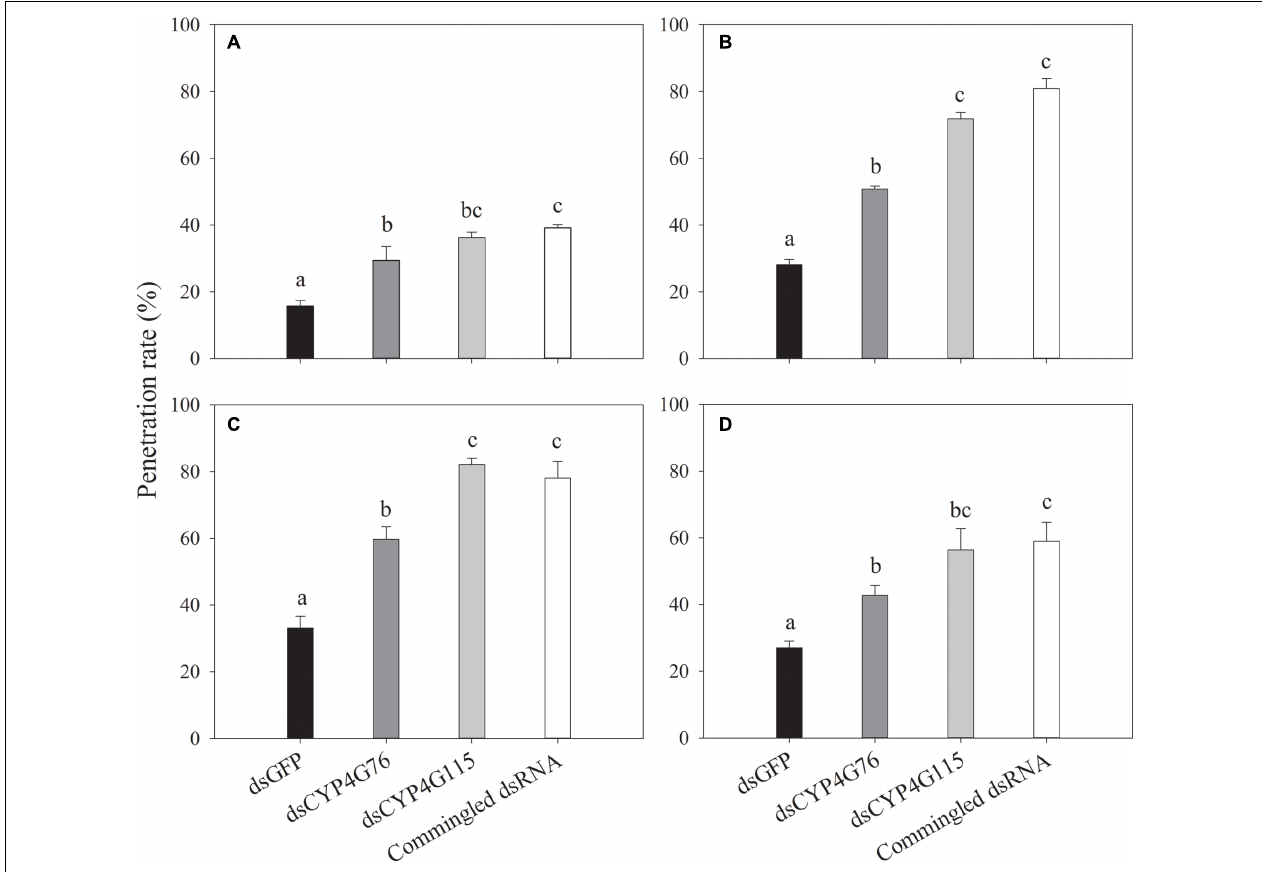
FIGURE 8 | Effect of RNAi suppression of CYP4G76 and CYP4G115 on the penetration rate of four insecticides: (A) buprofezin, (B) imidaclprid, (C) thiamethoxam, and (D) pymetrozine, in Nilaparvata lugens nymphs after 8 h of exposure. Mean ± SE was calculated from three biological replicates, and each biological replicate contained ten fourth instar N. lugens nymphs. Different lowercase letters in each figure showed the significant difference (ANOVA, LSD, p < 0.05).